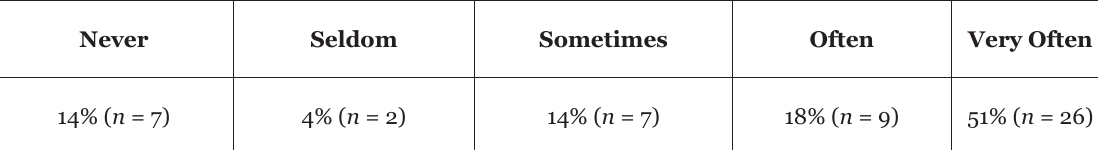
None One Course Two Courses Three Courses Four 25% ( n =